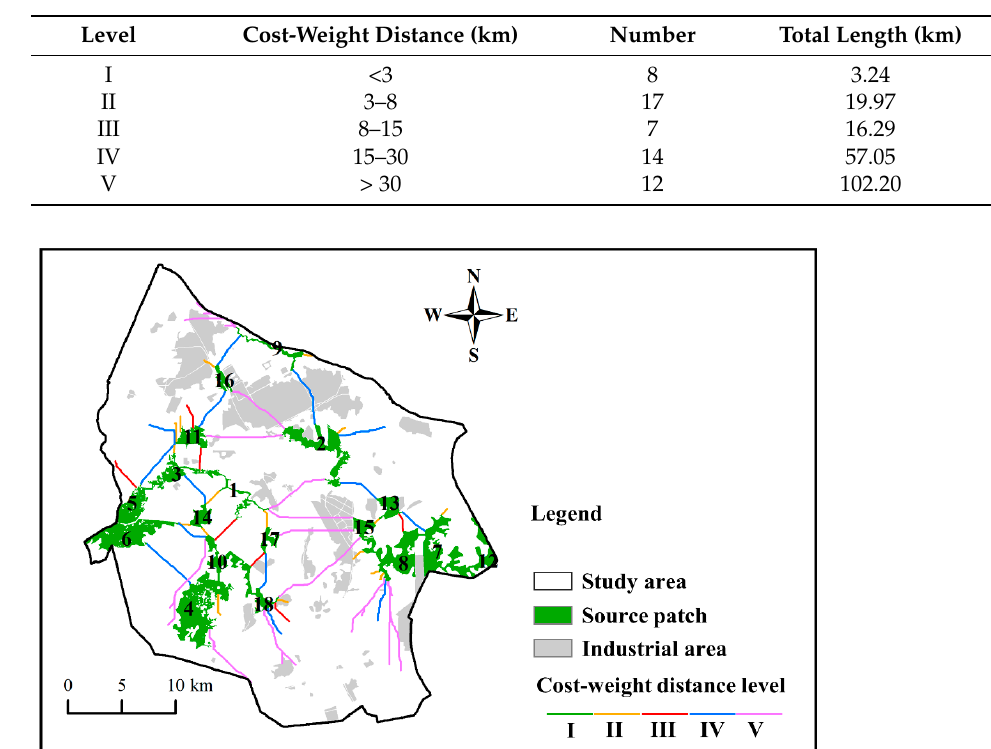
Table 10. Statistics of the ecological corridors for different level.